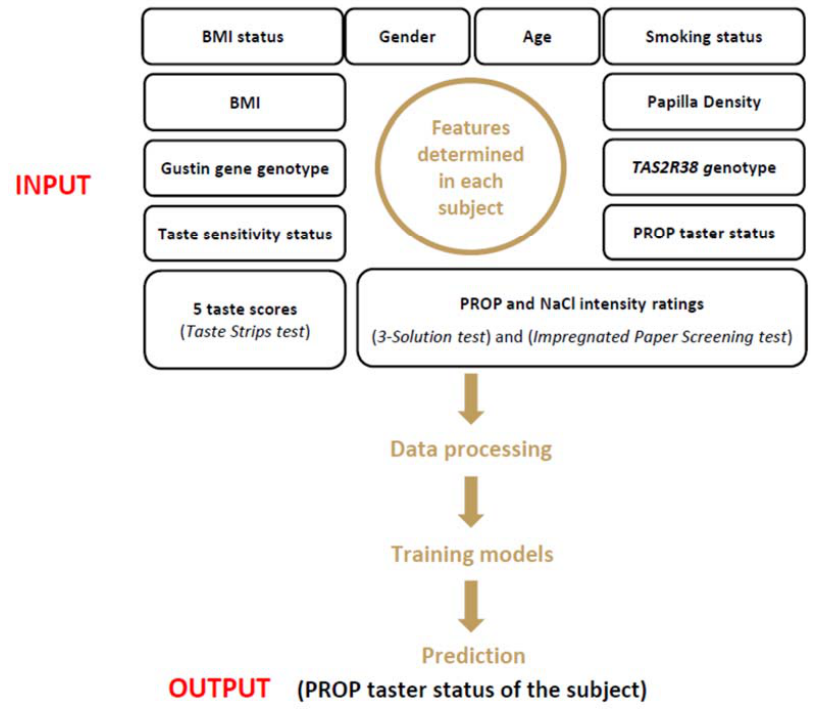
Figure 1. Graphic diagram representing the study design.